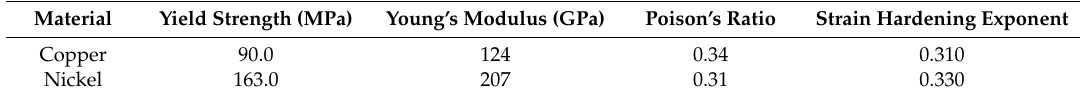
Table 1. The mechanical properties of copper and nickel [33].